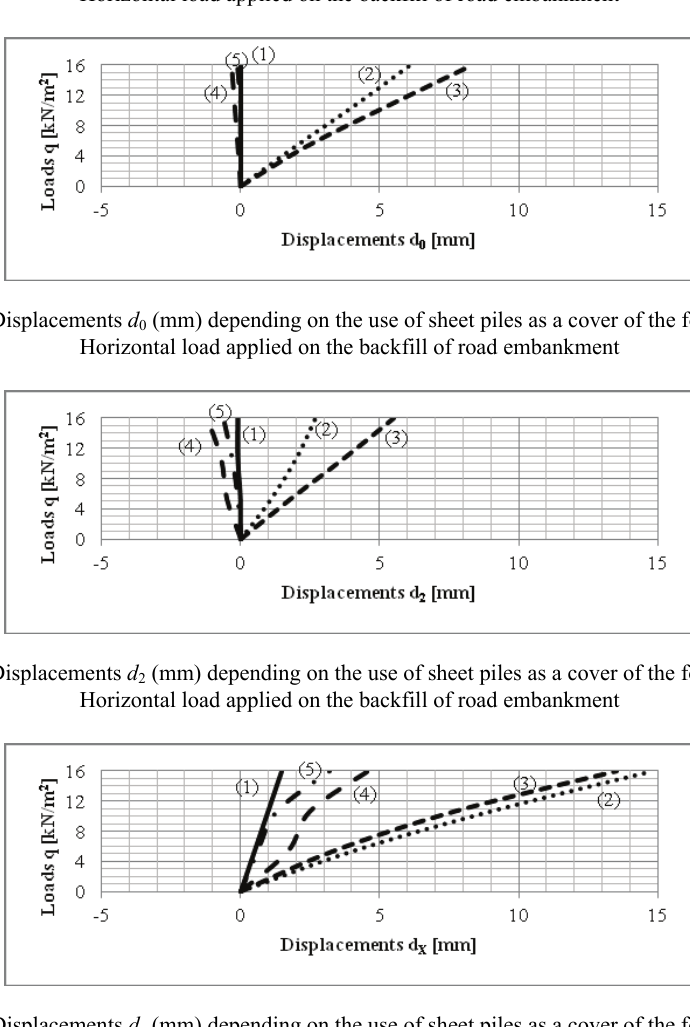
Fig. 7d. Displacements d x (mm) depending on the use of sheet piles as a cover of the foundation. Horizontal load applied on the backfill of road